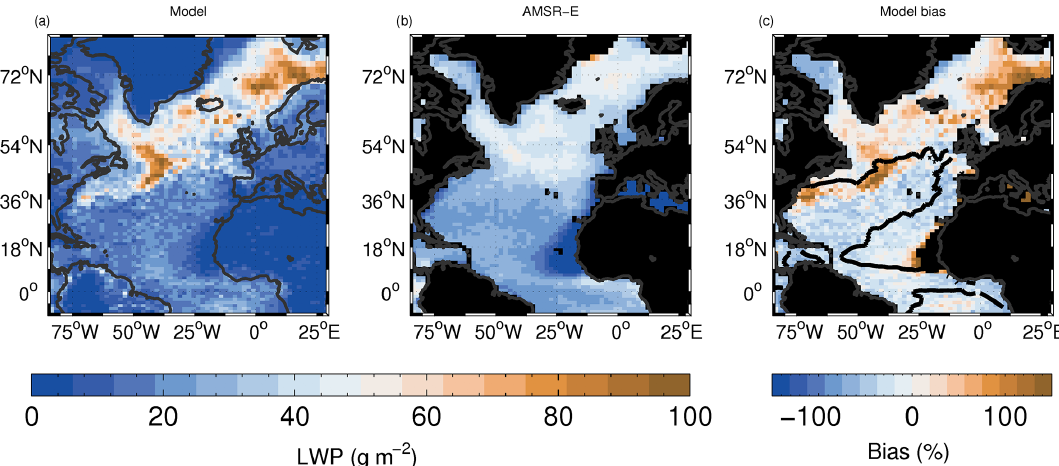
Figure D2. As for Fig. D1 except both the model and satellite data have been filtered before time averaging to only include data points for which f LWP is greater than 0.99. This quantity is denoted as LWP 0 . 99